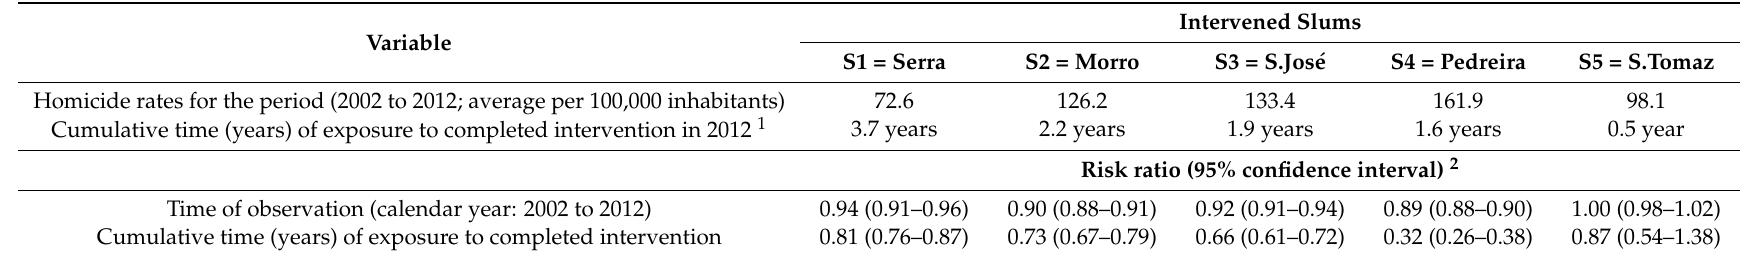
Table 3. Homicide rates, risk ratios by calendar year and exposure time of